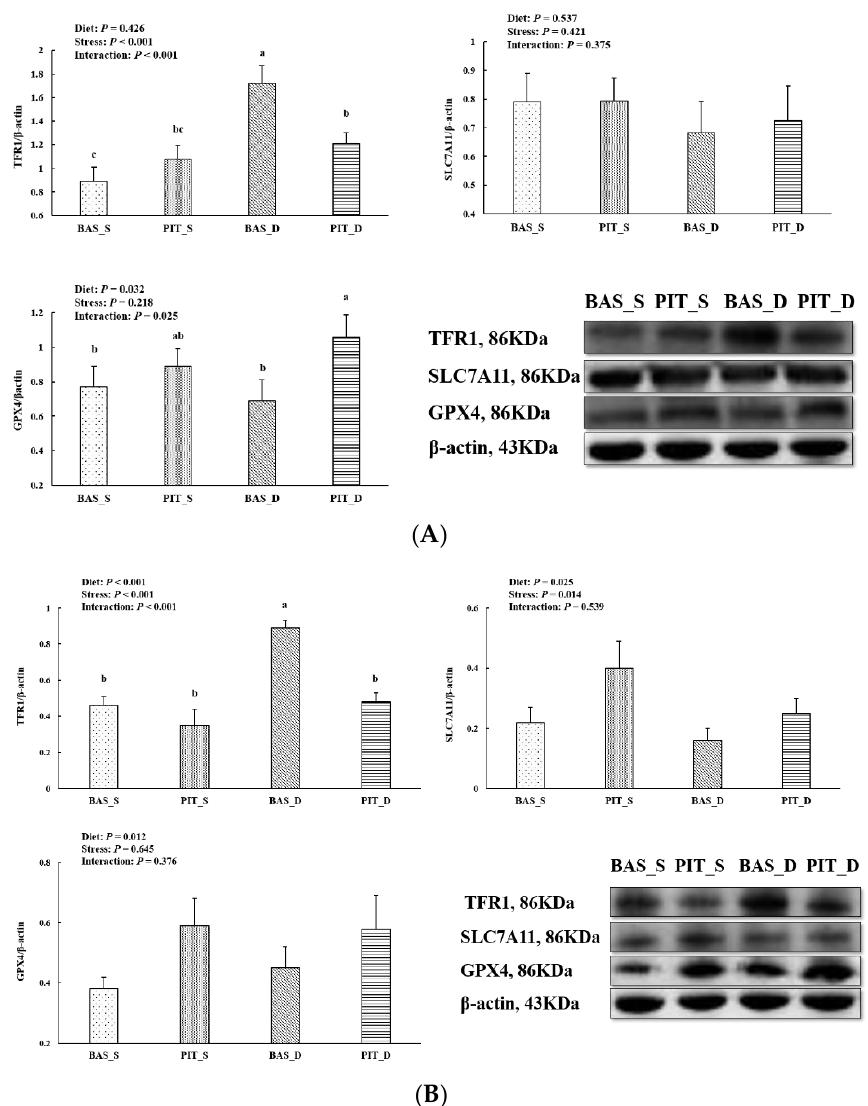
Figure 4. The jejunal ( A ) and ileal ( B ) mucosal protein abundance of ferroptosis-related signals of the piglets fed polyphenols sourced from Ilex latifolia Thunb. (PIT) diets under oxidative stress. The bands were the representative Western blot images. Values are mean and pooled SEM, n = 8 (1 piglet per pen). BAS_S, piglets fed the basal diet and injected with saline; PIT_S, piglets fed the PIT diet and injected with saline; BAS_D, piglets fed the basal diet and challenged with diquat; PIT_D, piglets fed the PIT diet and challenged with diquat. Different letters are significantly different between the treatment